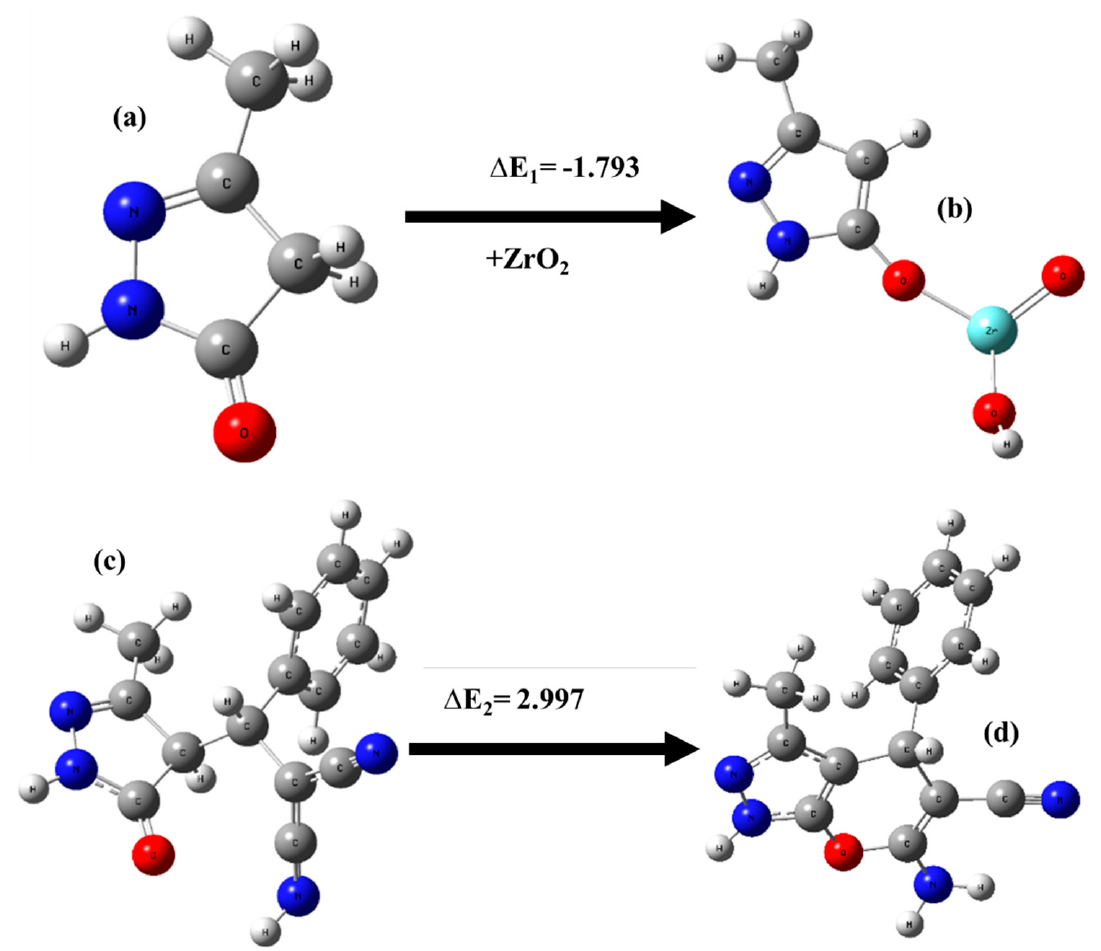
Figure 3. Computed intermediate reaction path and energy difference ∆ E in cal/mole.